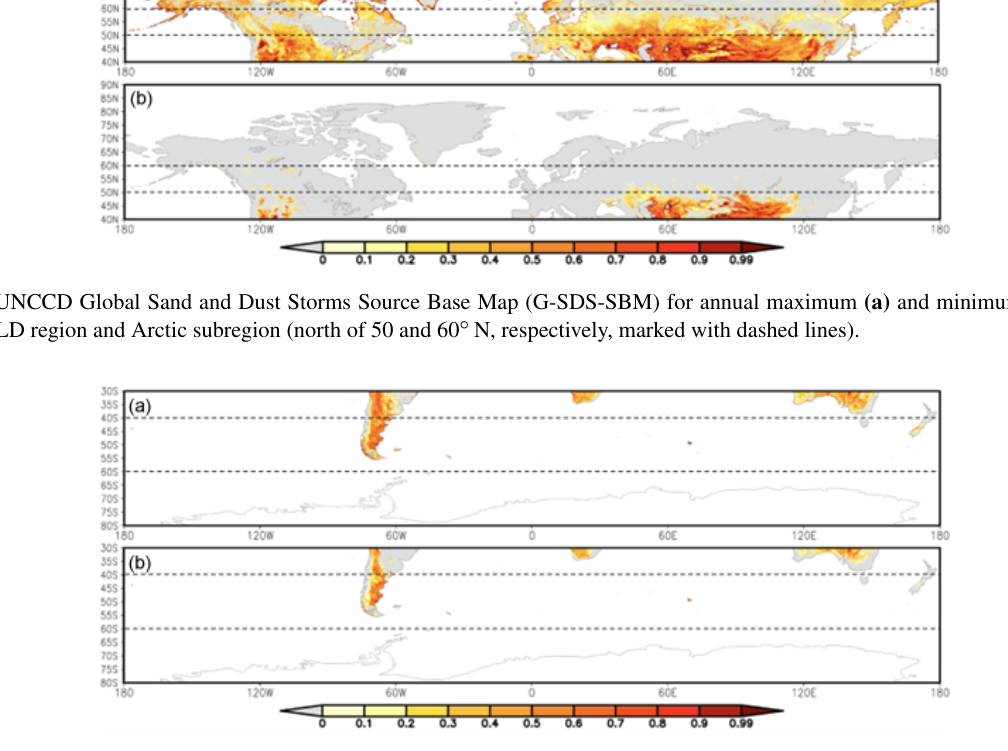
Figure 3. UNCCD G-SDS-SBM for annual maximum (a) and minimum (b) SI for the southern HLD region (south of 40 ◦ S) without Antarctica (south of 60 ◦ S), marked with dashed